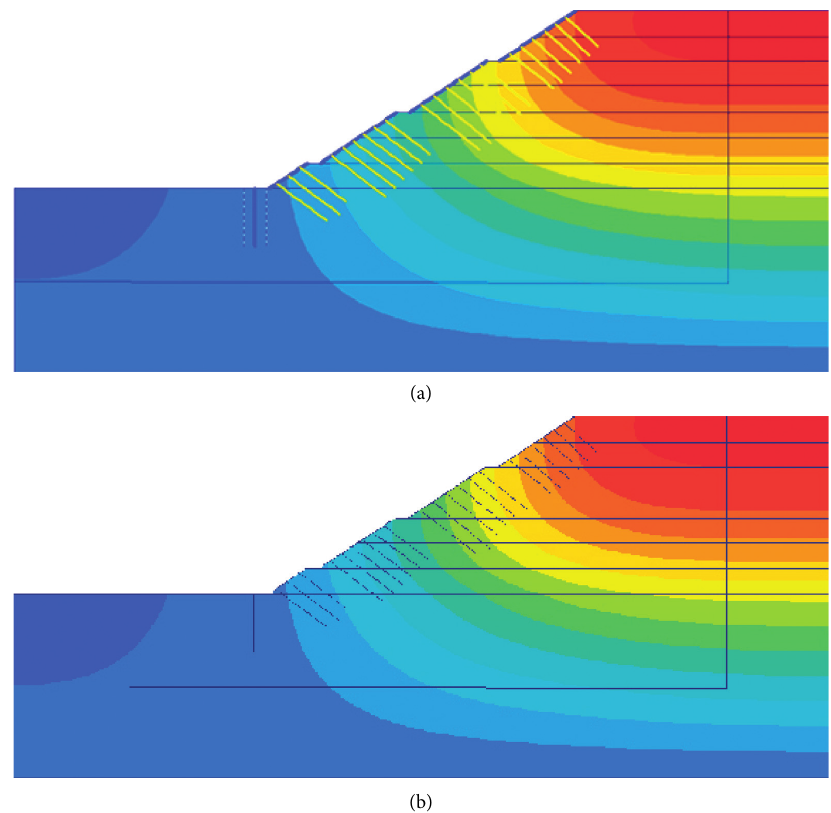
Figure 5: Vertical displacement nephogram when the reinforcement active or inactive. (a) Reinforcement active. (b) Reinforcement